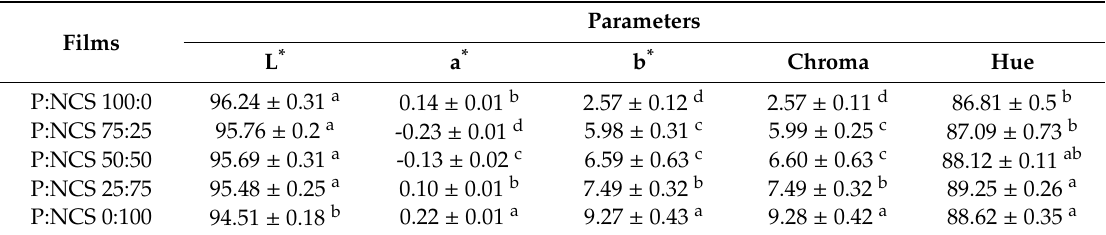
Table 4. Color of Table 4. Color of films.